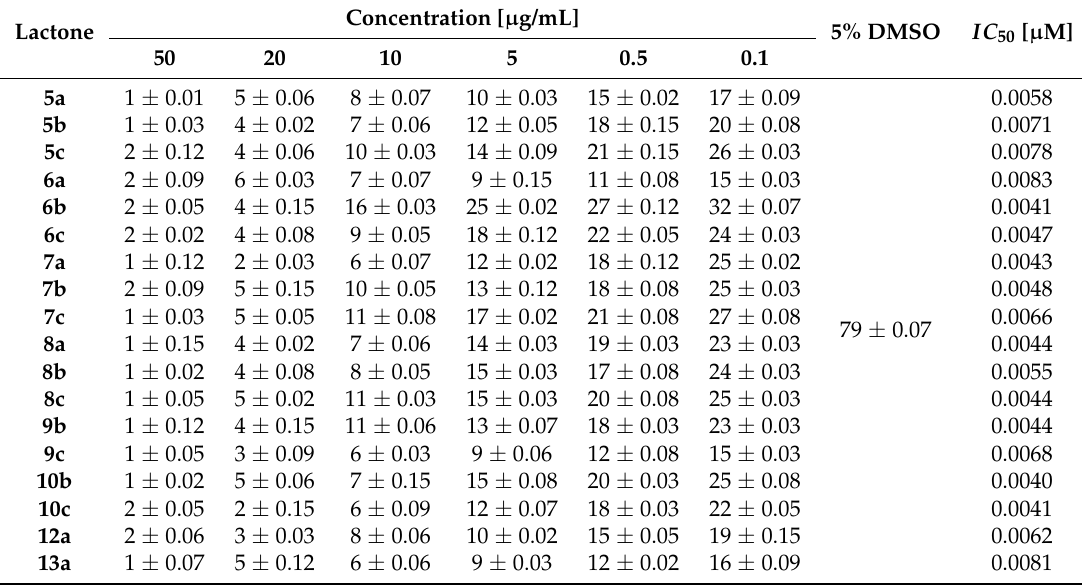
Table 5. The cytotoxic activity of tested lactones against L929 cell